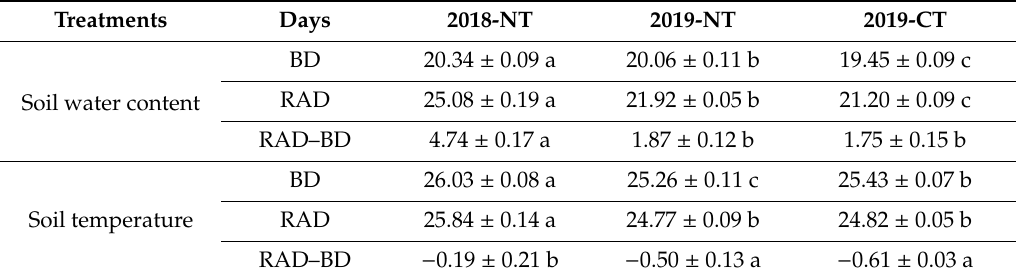
Figure 3. Soil water content ( A ) and soil temperature ( B ) in response to tillage practices during maize growth stages in 2018 and 2019. Table 2. Mean (±SE) soil water content (cm 3 cm − 3 ) and soil temperature (°C ) in response to tillage practices in 2018 and 2019.